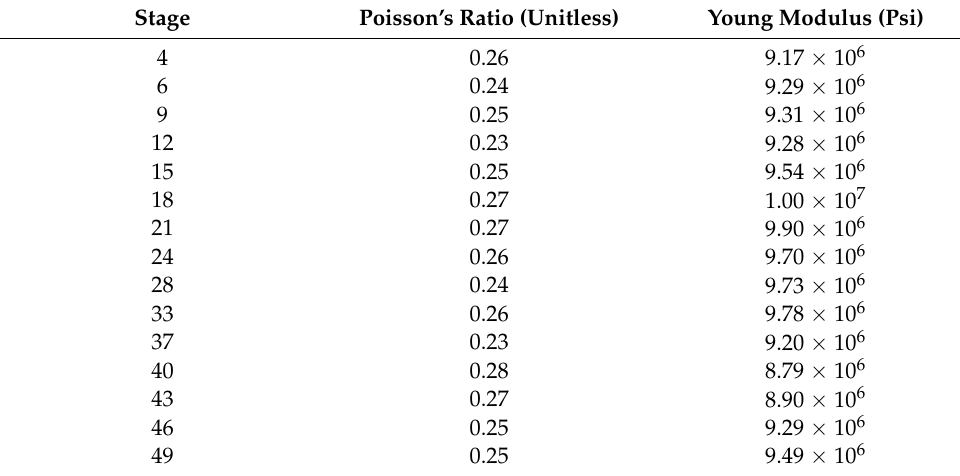
Table 7. Geomechanical properties for 15 selected